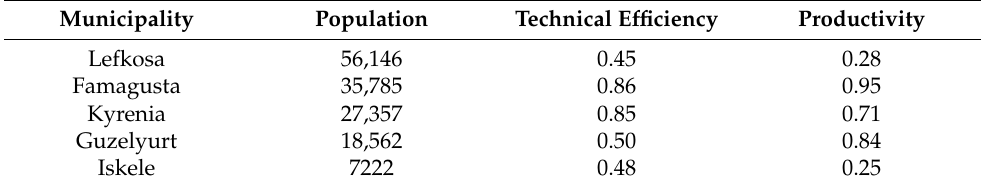
Table 10. Analysis of Population Size and Efficiency of Government (2018).